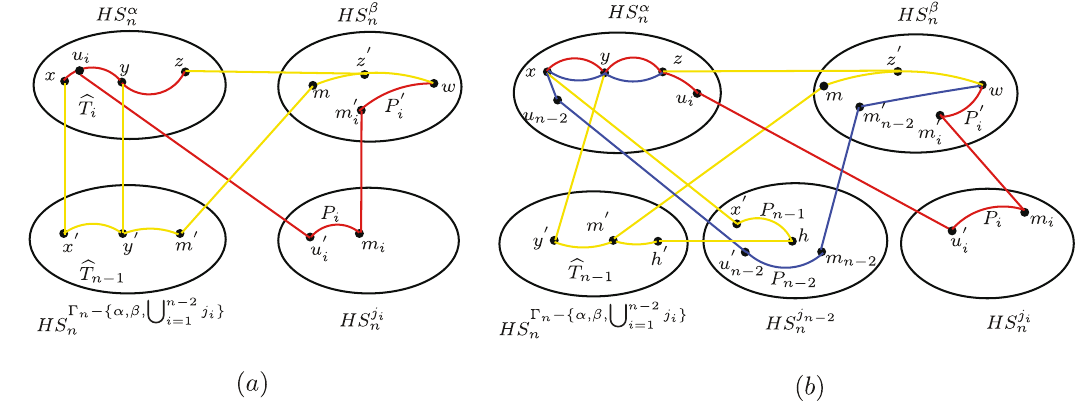
Figure 6: The illustrations of ( ) ∈ z N : ( a ) Case 2.2.2.1 and ( b ) Case { }